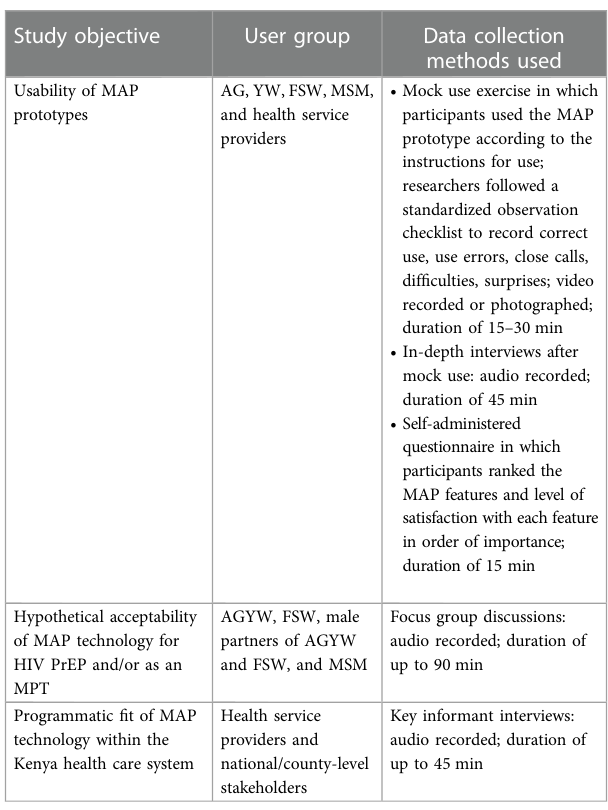
TABLE 1 Data collection methods, by study